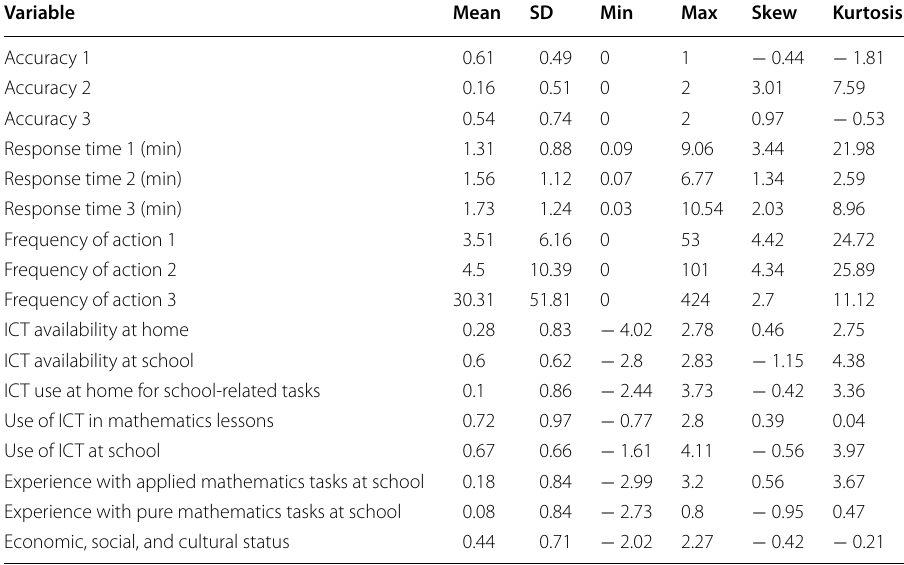
Table 13 Descriptive analysis of the indicators in their original metrics for Norway